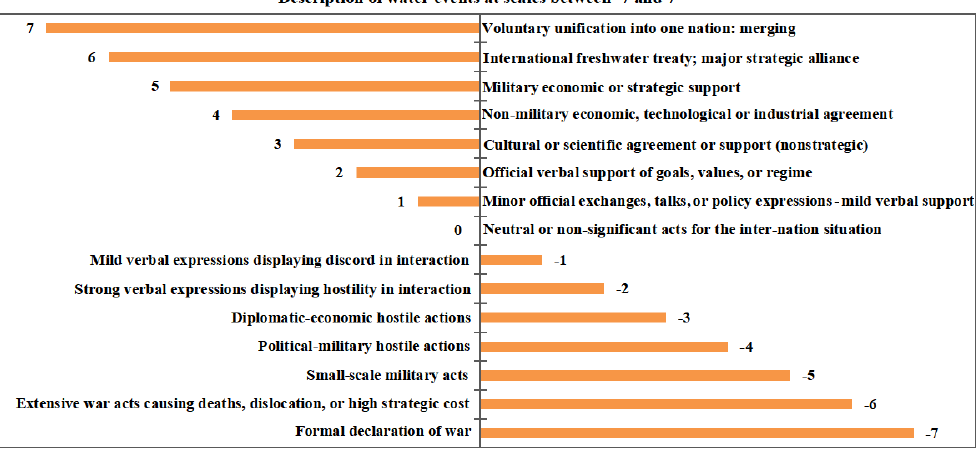
Figure 2. Classification criteria for water-related political